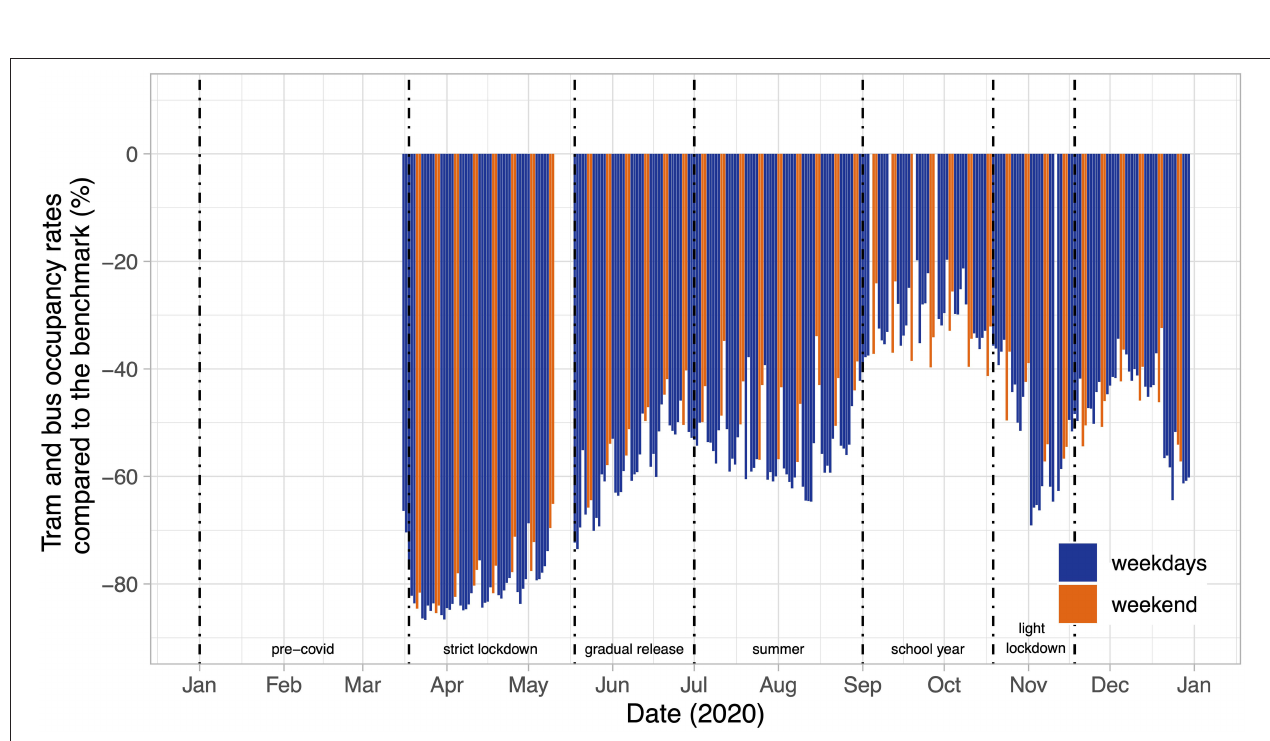
FIGURE 6 | Evolution of the city public transport occupancy rates (trams and busses) compared to their pre-lockdown benchmark (source: STIB-MIVB). Days with unusual values justified by special events were retrieved, by the operator, from the dataset.